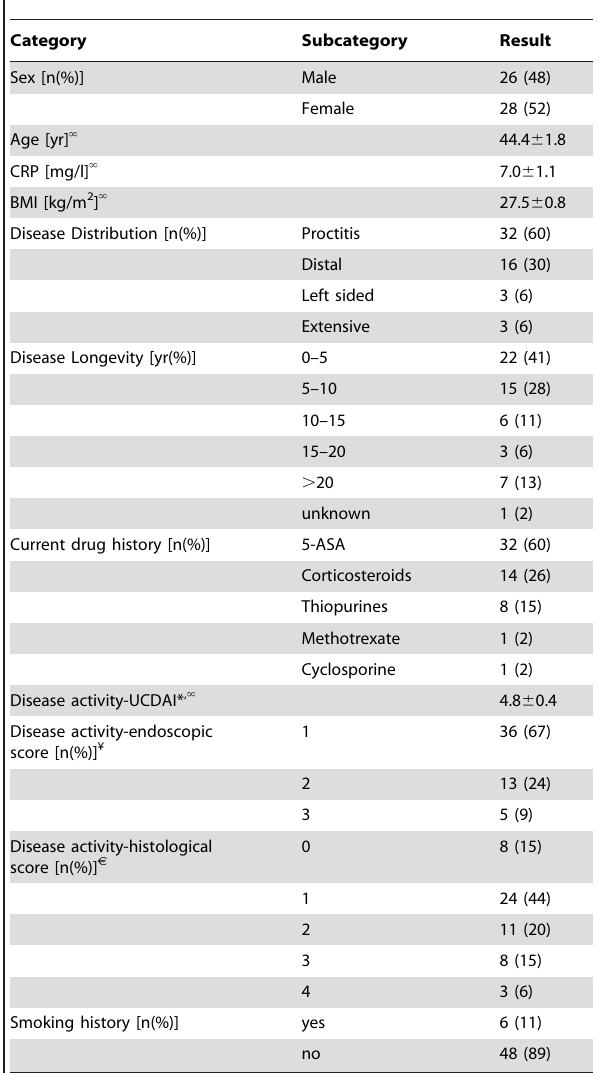
Table 1. Baseline characteristics of patients with active UC. Table 2. Lipid mediator concentrations (pg/mg tissue) in colonic mucosa (inflamed and non-inflamed) in UC